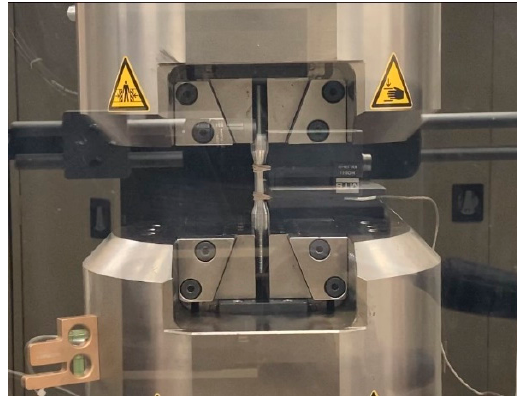
Figure 3. Experimental set-up.